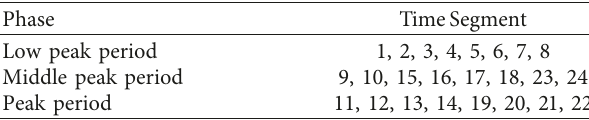
Table 2: Periods of electricity